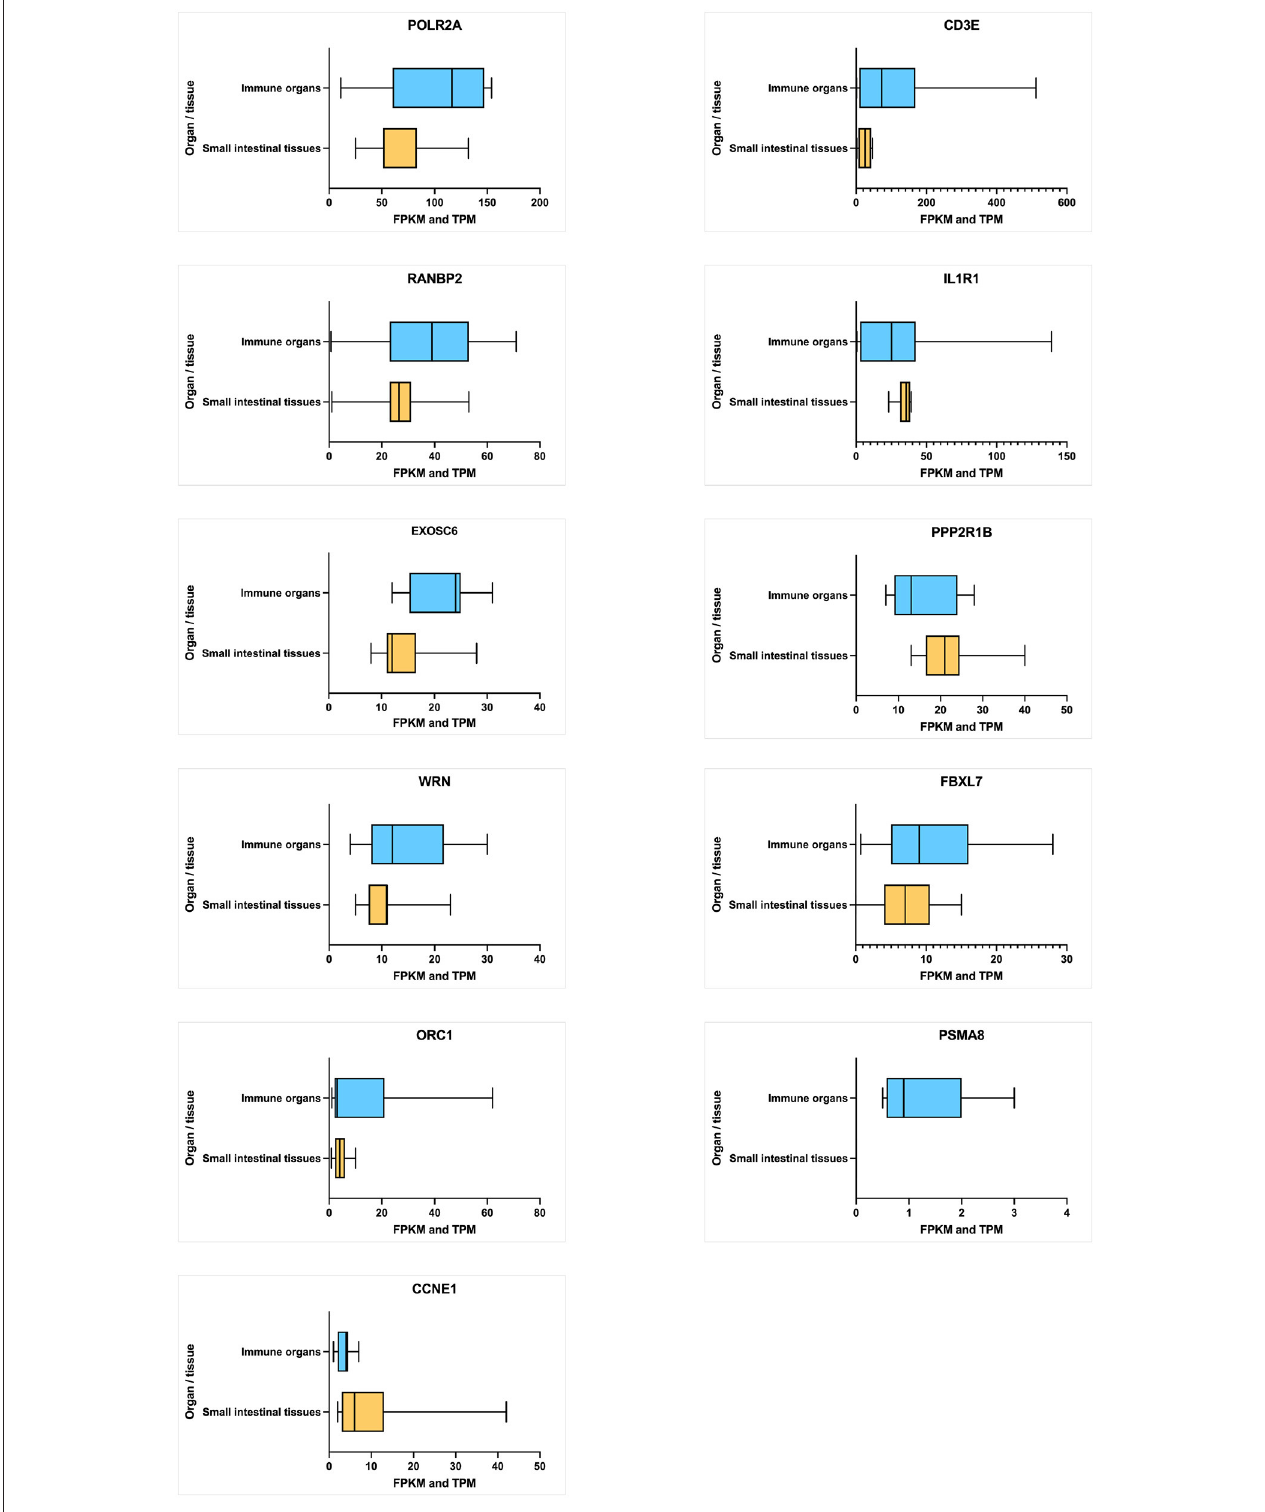
FIGURE 6 | Average level of hub gene expression reported in transcriptomic gene expression databases provided by Ensembl. Small intestinal tissues include the small intestine and duodenum tissue. Immune organs include the leukocyte, spleen, lymph node, thymus, Epstein–Barr virus (EBV)-transformed lymphocyte, bone marrow, and small intestine Peyer’s patch. Gene transcription levels are represented in TPM (transcripts per million). Transcription scale: low (0–10), medium (11–1000), and high ( > 1,000). The figure is generated using GraphPad Prism 9.2.0 software.